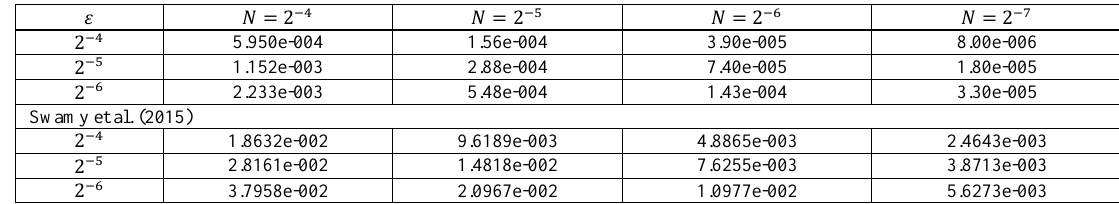
Table 4. The maximum absolute error of example 2 for 𝜹 = 𝟎. 𝟓𝜺